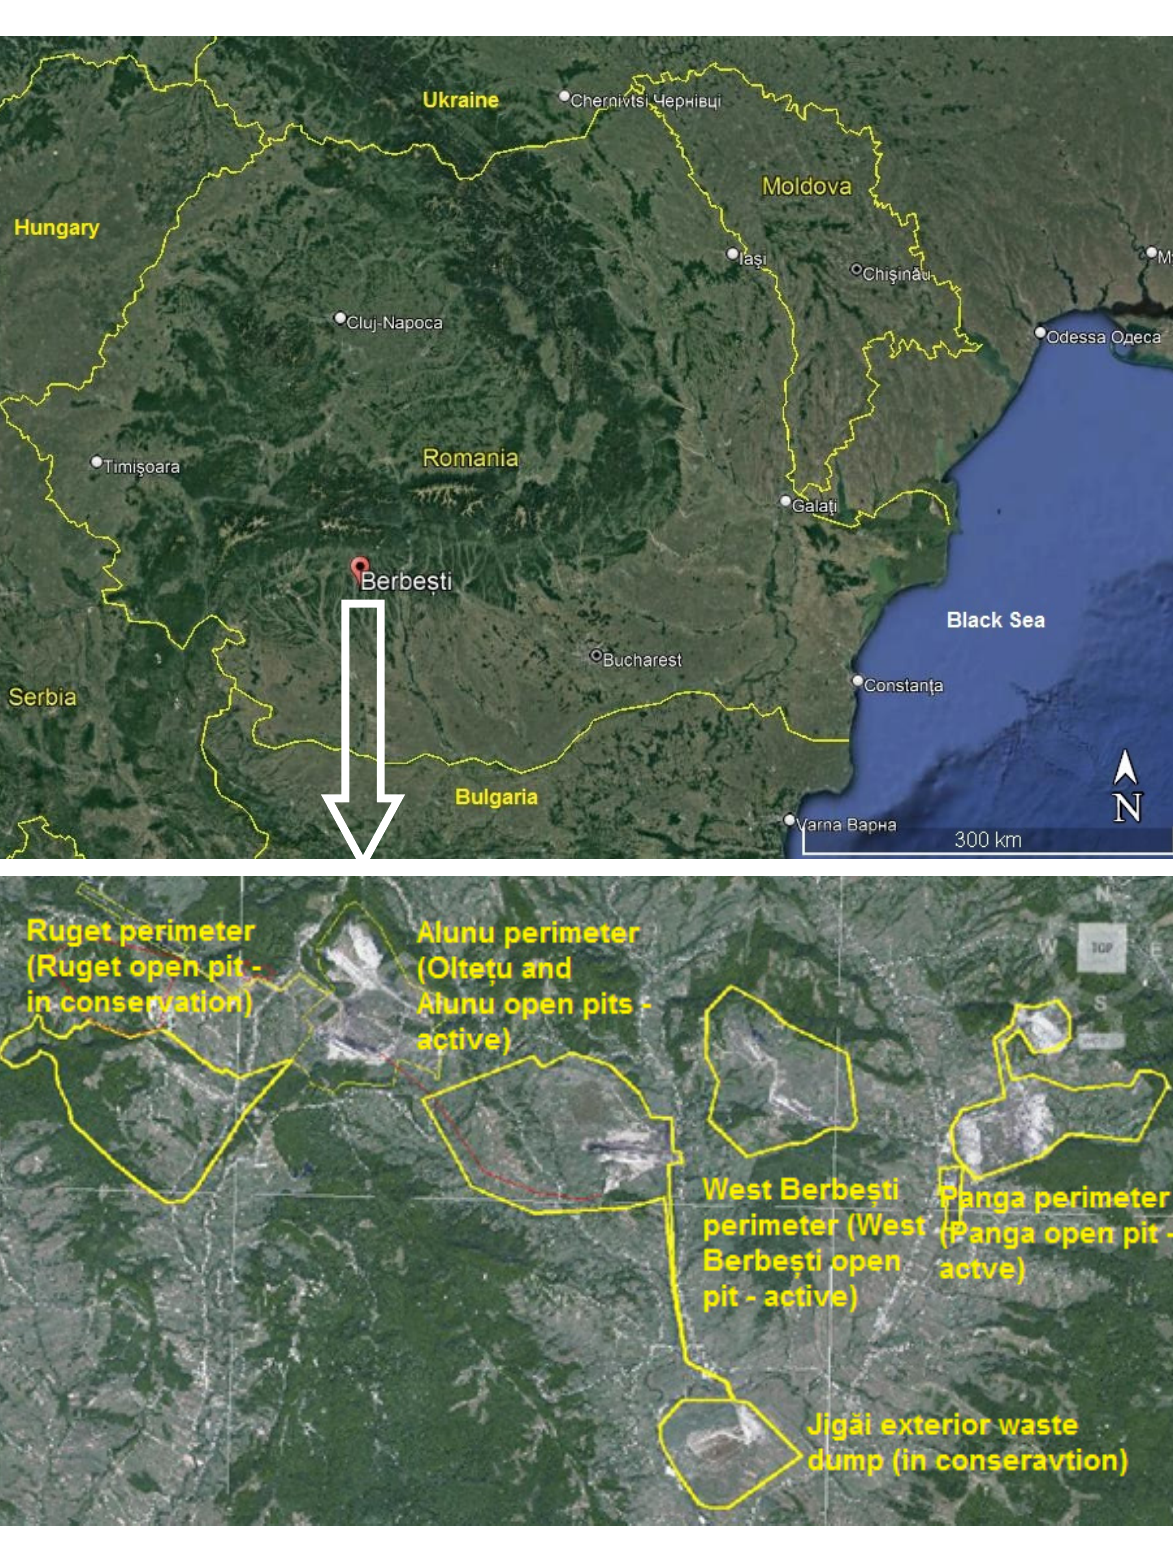
Figure 1. Berbe ş ti Mining Basin